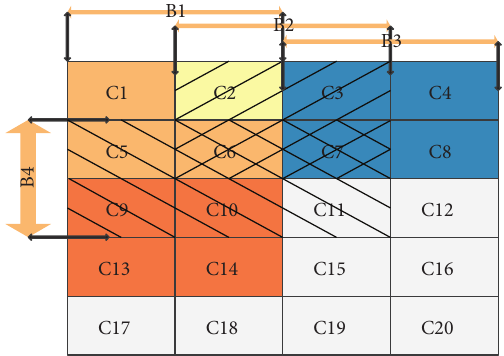
Figure 7: Blocks